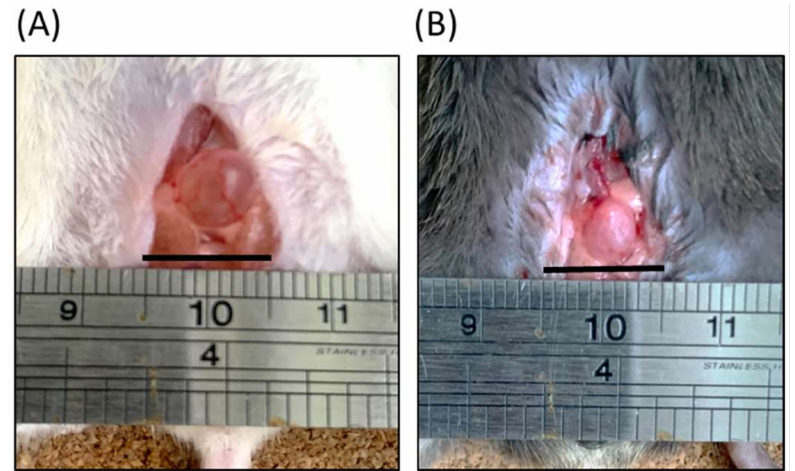
Figure 1. Gross examinations of bladders of ( A ) FVB/NJ (FVB, white) and ( B ) C57BL/6J (B6, black) mice. The iron ruler is displayed for scale. FVB bladder was larger than B6 bladder. Black bar indicates one